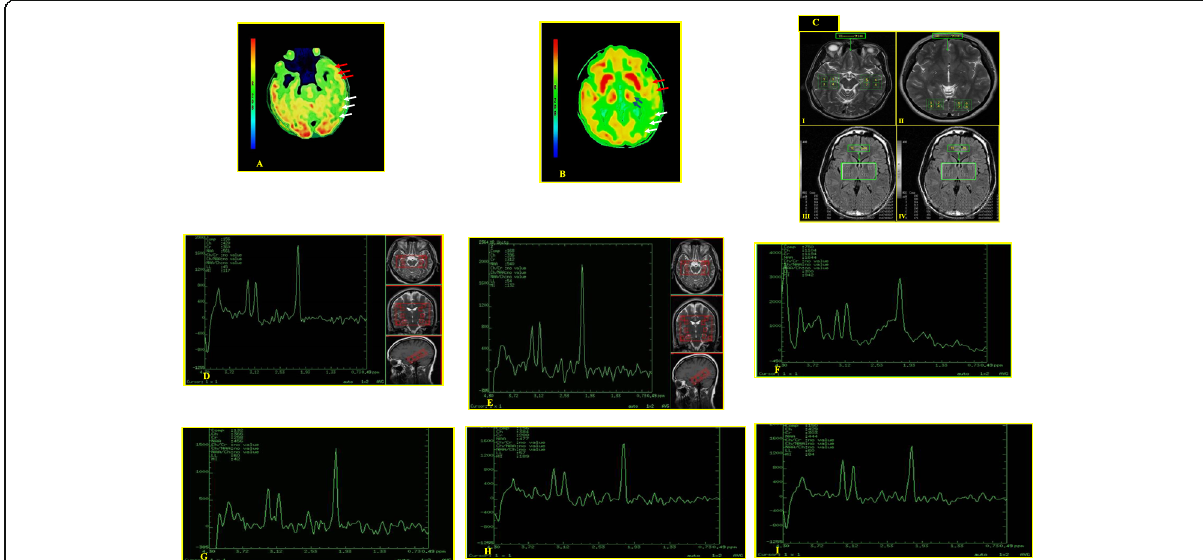
Fig. 3 a – i A 40-year-old male patient with non-lesional left temporal lobe FIAE. The visual-based analysis of the axial PASL-MRI colour-coded cerebral perfusion maps ( a and b ) reveals a focal hypoperfusion of the epileptogenic left temporal lobe (red arrows), the ipsilateral occipital lobe that represents the area of seizure spread (white arrows) and the ipsilateral thalamus (blue arrows). The estimated rCBF for the right and left temporal lobes was 69.78 and 50.03 ml/100 g/min, respectively, with ASLAI% of 32.97%, as well as that of the right and left occipital lobes was 71.22 and 66.82 ml/100 g/min., respectively, with ASLAI% of 6.37%, while the estimated rCBF of the right and left thalami was 68.89 and 62.19 ml/ 100 g/min, respectively, with ASLAI% of 9.50%. The MV 1H-MRS picture maps illustrating the studied ROIs in ( c ) (I – IV). The MRS spectra of the right and left temporal lobes ( d and e , respectively), as well as the right and left occipital lobes ( f and g , respectively), in addition to the right and left thalami ( h and i , respectively), demonstrated increased MI/NAA, Glx/NAA and Glx/Cr, as well as decreased NAA/(Cho + Cr) ratios in the zone of epileptogenic activity in the left temporal lobe ( e ) in comparison to the contra-lateral temporal lobe (d), while the ipsilateral left occipital lobe ( g ) and the ipsilateral thalamus ( i ) showed decreased MI/NAA and NAA/(Cho + Cr), as well as increased Glx/NAA and Glx/Cr ratios, when compared to their corresponding contra-lateral regions. For the right and left temporal lobes, these ratios were [NAA/(Cho + Cr) = 0.72 and 0.65 with %AF of 10.22%, MI/NAA = 0.21 and 1.07 with %AF of 13.44%, Glx/NAA = 1.25 and 1.61 with %AF of 25.17% and Glx/Cr = 1.22 and 1.50 with %AF of 20.58%]. For the right and left occipital lobes, these ratios were [NAA/(Cho + Cr) = 0.72 and 0.67; with %AF of 7.25%, MI/NAA = 0.38 and 0.27 with; %AF of 72.13%, Glx/NAA = 1.33 and 1.65 with %AF of 21.48% and Glx/Cr = 1.30 and 1.59, with %AF of 20.07%]. For the right and left thalami, these ratios were [NAA/(Cho + Cr) = 0.71 and 0.61 with %AF of 15.15%, MI/NAA = 0.40 and 0.19 with %AF of 71.18%, Glx/ NAA = 1.31 and 1.57 with %AF of 18.06% and Glx/Cr = 1.29 and 1.54, with %AF of